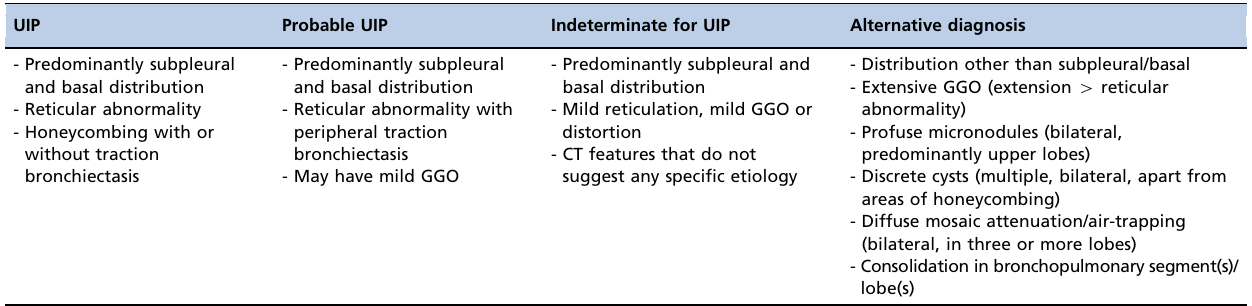
- Predominantly subpleural and basal distribution - Mild reticulation, mild GGO or distortion